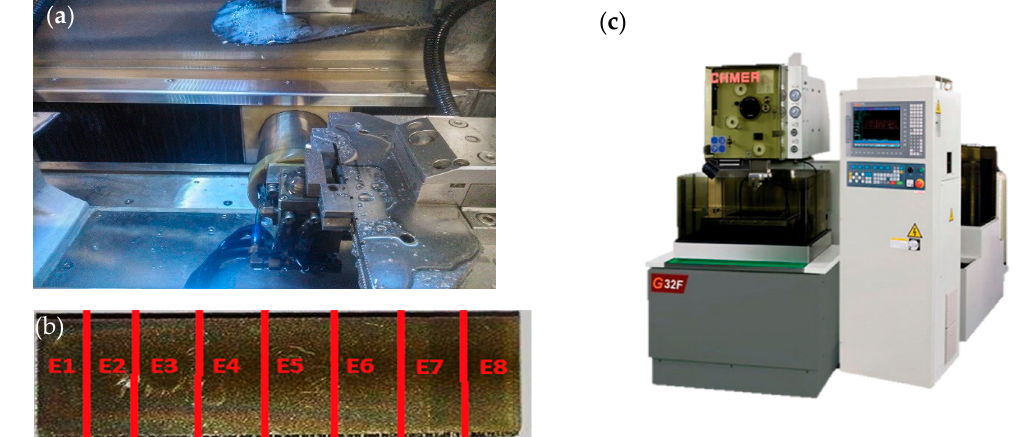
Figure 2. Made of experimental samples from maraging steel MS1 by µ-WEDM. ( a ) µ-WEDM process of the specimens; ( b ) marking of roughing sections E1 to E8, ( c ) the used electroerosive machine CHMER G32F.